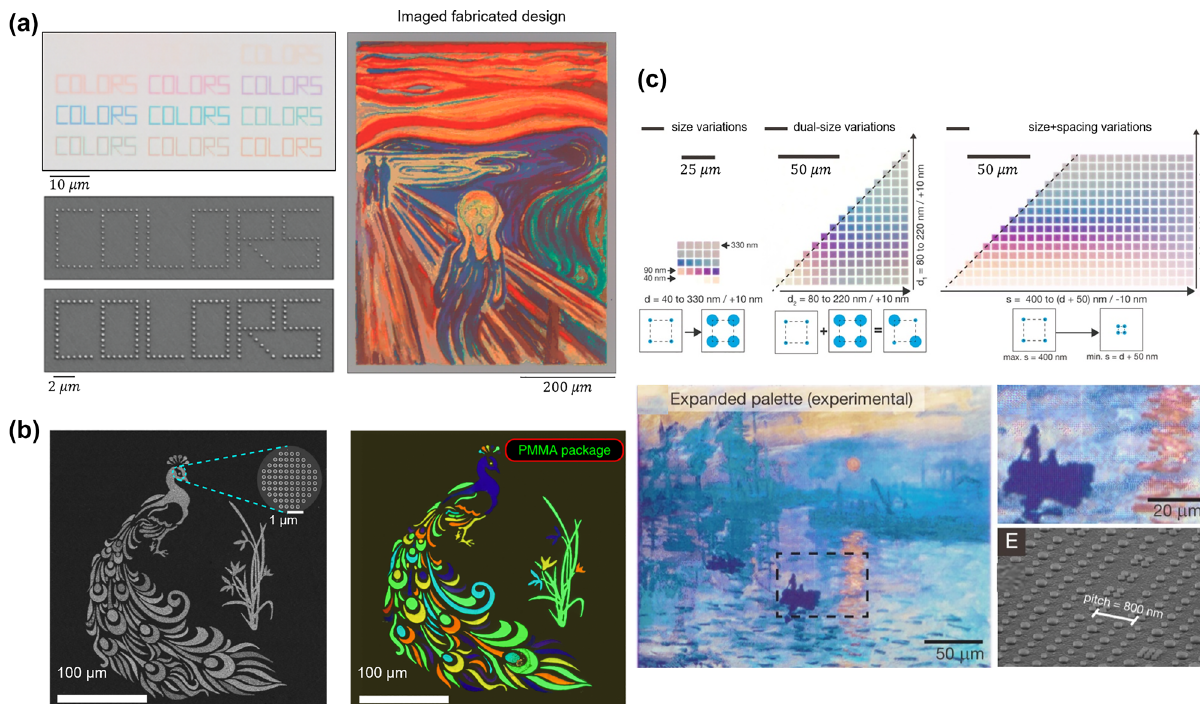
Figure 35: Structural color printing with high purity and large gamut coverage. (a) Si-based structural colors. Left panel: Micrograph of the word “COLORS” printed with single Si nanodisks of different diameters, and SEM images of two “COLORS” patterns. Right panel: Optical micrograph of the painting “The Scream” reproduced by the Si-based structural colors. Modified with permission [340]. Copyright 2021, American Chemical Society. (b) SEM image of the sample “peacock with an orchid” and bright-field microscope image of the sample packaged with a PMMA index matching layer. Modified with permission [166]. Copyright 2020, Nature Publishing Group. (c) Upper panel: color mixing strategy for Al color pixels, where the basic color pixel is formed by four identical nanodisks; Lower panel: reproduction of Monet’s “Impression, Sunrise” using the expanded palette of Al color pixels and an associated SEM image of the sample. Modified with permission [341]. Copyright 2014, American Chemical